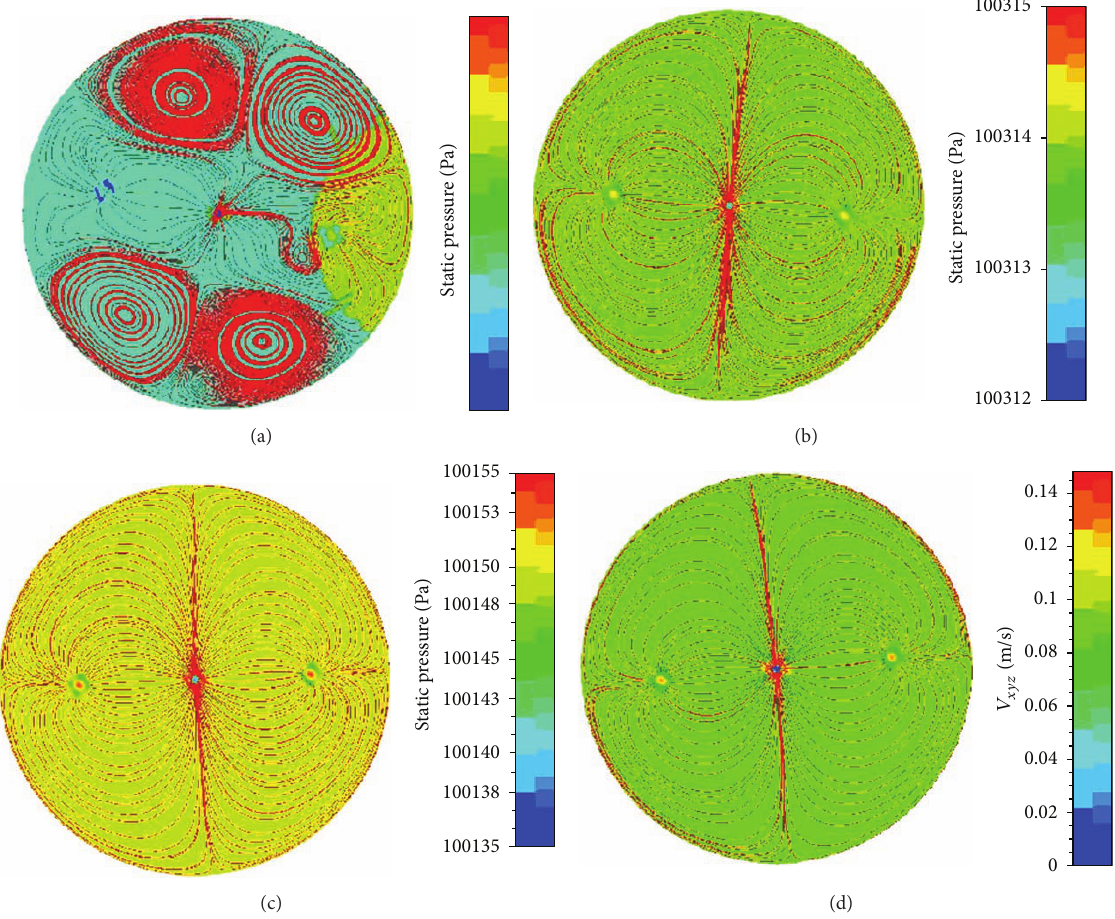
Figure 12: The simulation results of micro flow: (a) the flow field distribution when the flow rate is 3 × 10 −7 kg/s,(b) the flow field distribution when the flow rate is 3 × 10 −5 kg/s, (c) the flow field distribution when the flow rate is 3 × 10 −4 kg/s, (d) the flow field distribution when the flow rate is 2 × 10 −7 kg/s.